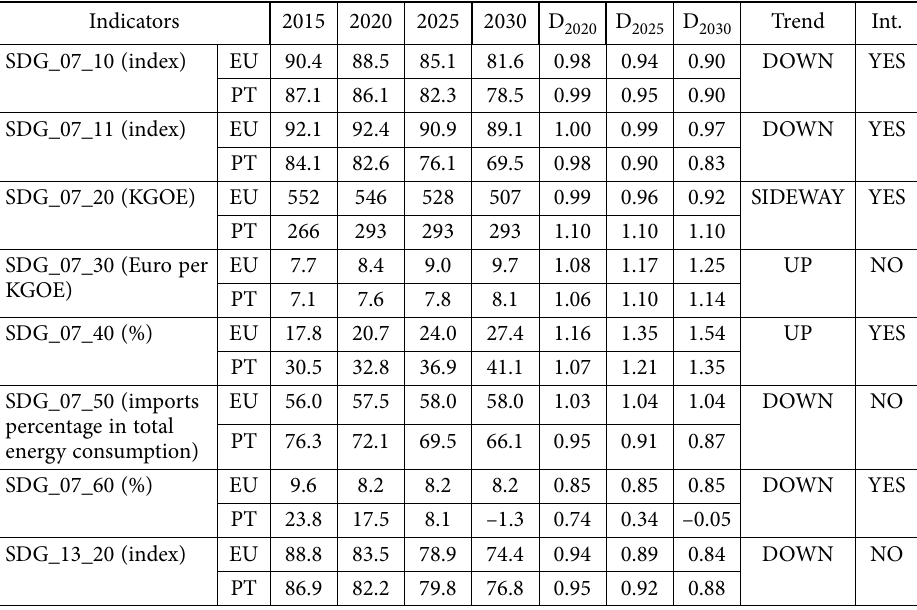
Table 8. SDG 7 – Affordable and clean energy